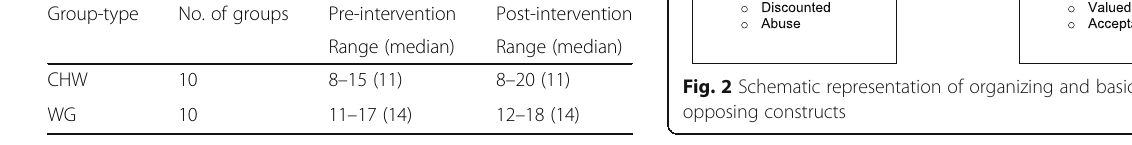
Table 1 Summary of community group attendance: pre- and post-intervention Group-type